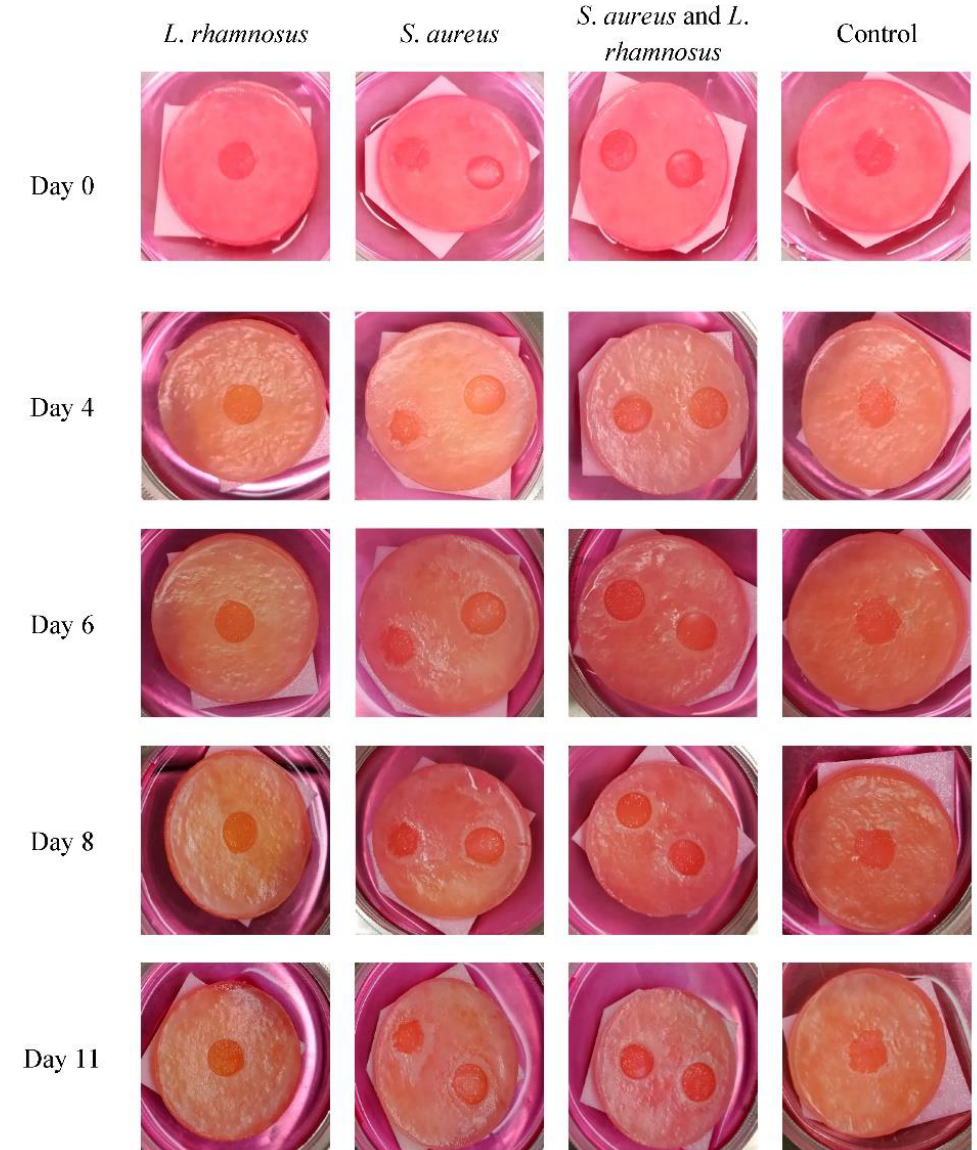
Figure 11. Progression of the wound healing process in skin models. Macroscopic photo images of the human skin equivalents from day 0 to day 11. After 4 days, an orange color is observable due to lactic acid formation in the infected models, reflecting a drop in the pH. After day 6, contraction of the wound size is visible only in the models infected with L. rhamnosus . Models infected with S. aureus showed the presence of exudate visible as a white precipitate , as well as a delayed healing.